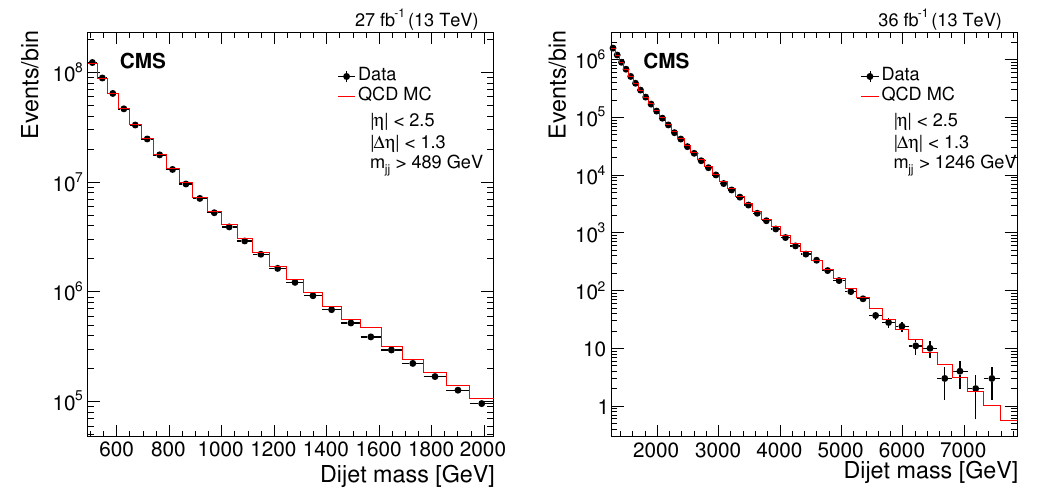
Figure 5 . The dijet mass of the two wide jets from the low-mass search (left) and the high-mass search (right). Data (points) are compared to QCD predictions from the pythia 8 MC including detector simulation (histogram) normalized to the data. The horizontal lines on the data points show the variable bin